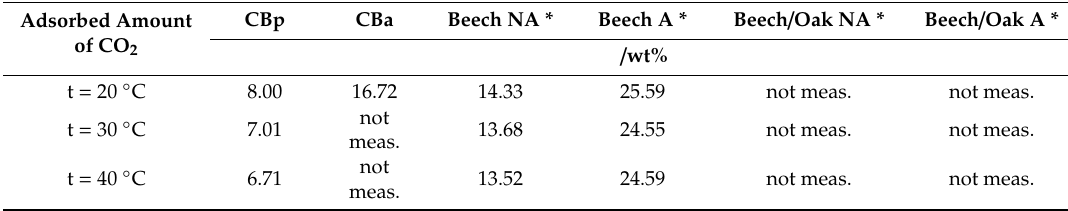
Table 2. Results of sorption capacity in the environment of CO 2 at a pressure of 2000 kPa, comparison of experimental and literature data [16].